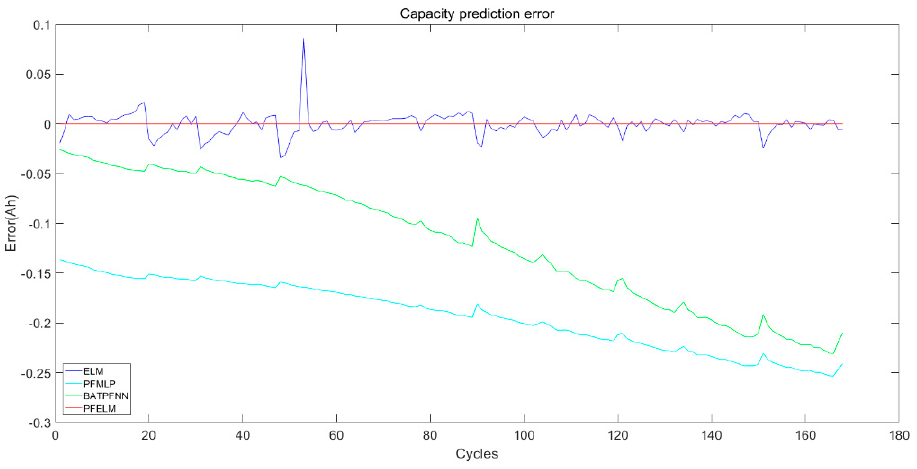
Figure 4. Predicting capacity from the first cycle by different algorithms: ( a ) ELM ; ( b ) perceptron prognosis model-based on particle filter (PFMLP); ( c ) BATPFNN; ( d ) PFELM.